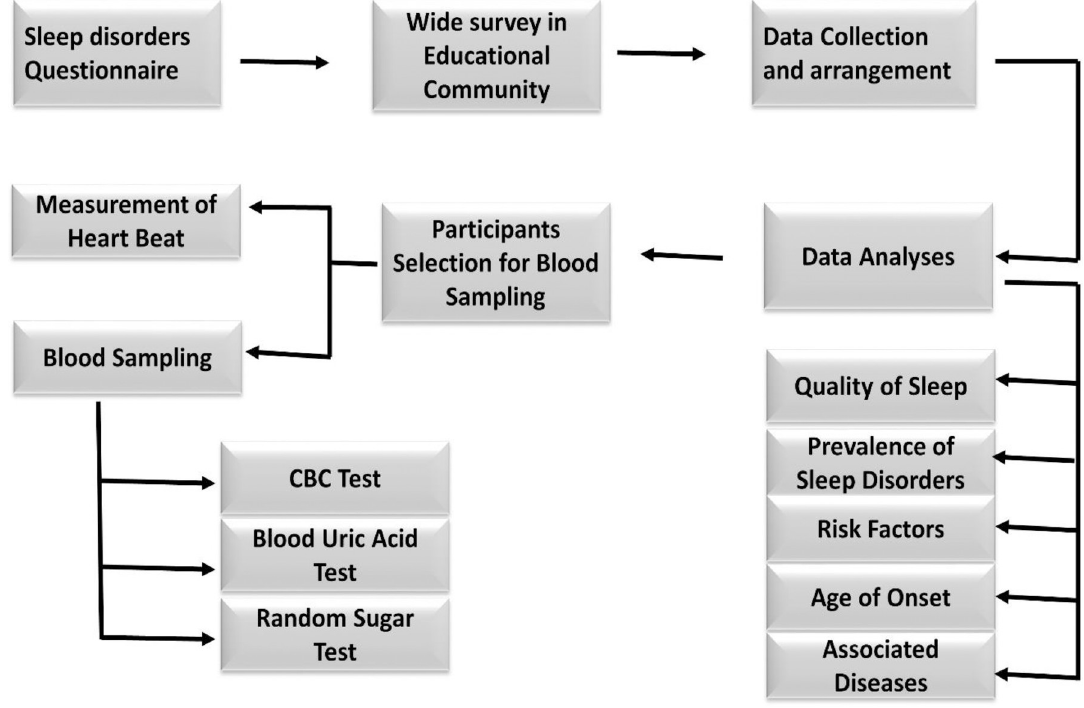
Fig 1. Flow sheet of research